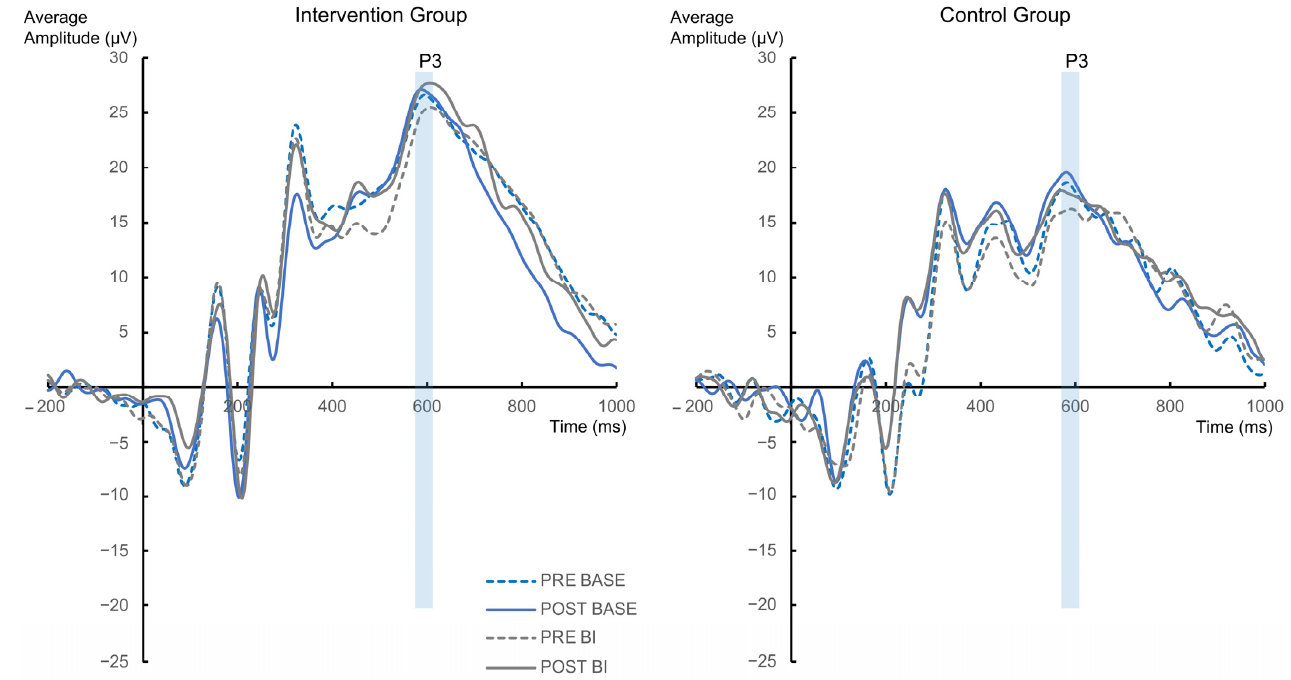
Figure 6. The P3 ERPs pooled across electrode PO1 and PO2 are presented for the intervention group and control group separately. Time point zero denotes the onset of the cue.